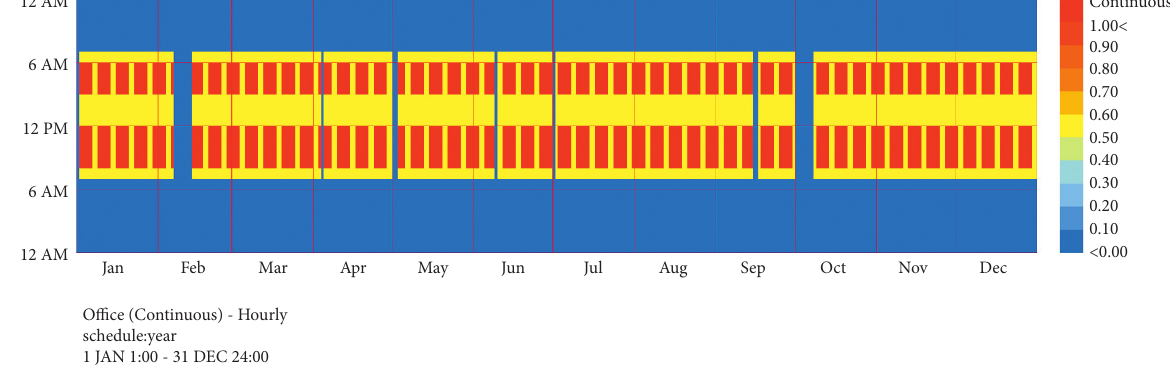
Figure 5: Sanya’s annual work and rest